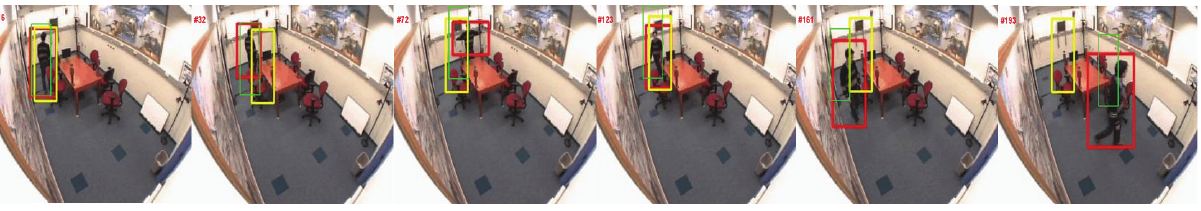
Figure 6: Tracking results of intelligent room sequence. Frames 16, 32, 72, 123, 161, and 193 are